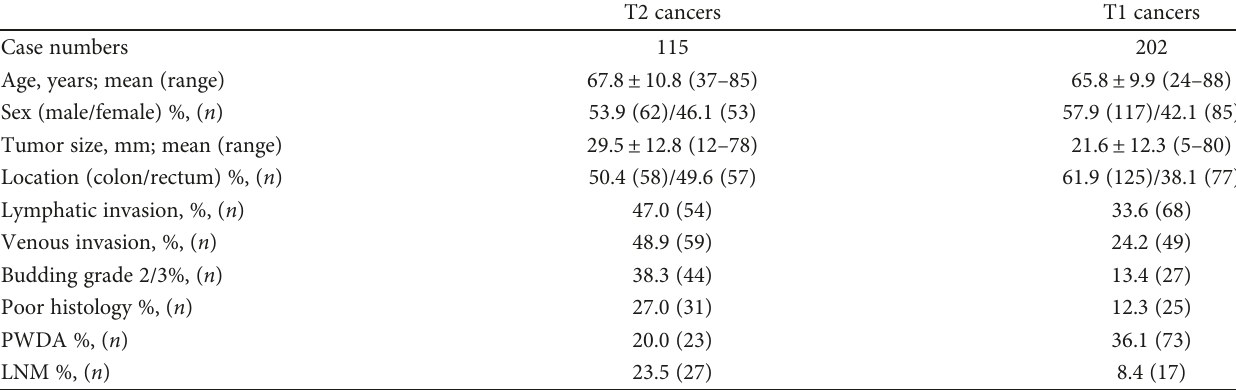
Table 1: Clinicopathological characteristics of 115 T2 and 202 T1 colorectal cancers.